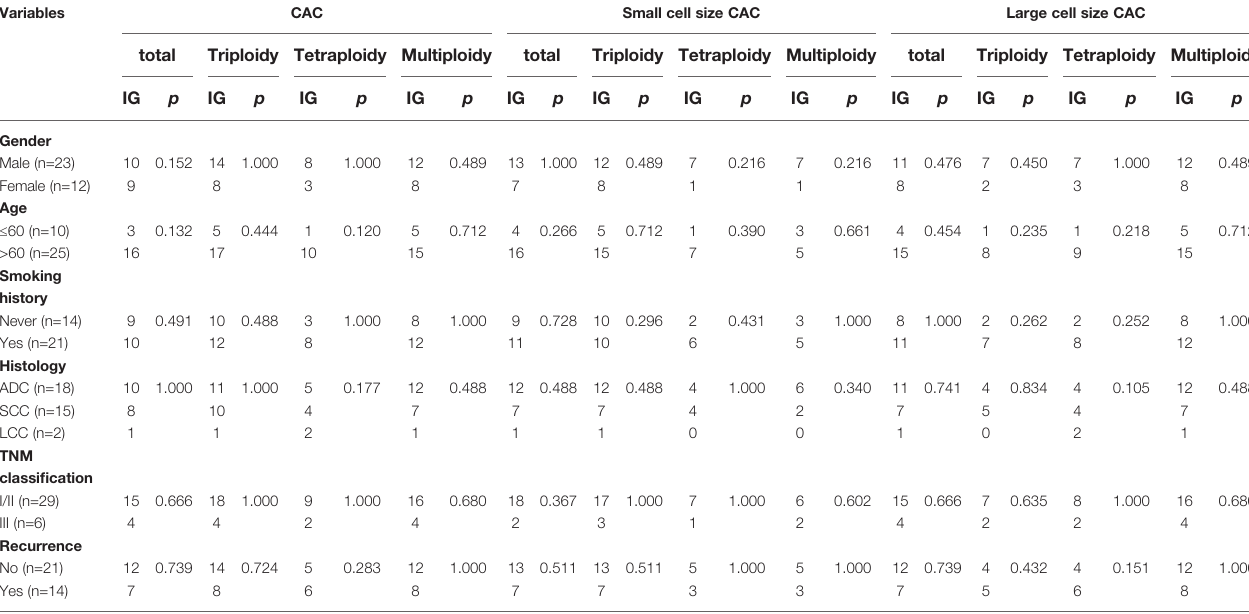
TABLE 8 | Correlations between clinical characteristics and CAC variations pre- and post-surgery in 35 NSCLC patients.